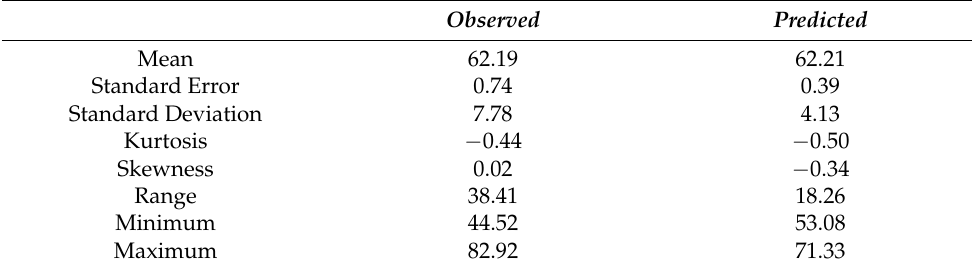
Table 7. Summary Statistics of the Observed and Predicted Noise Levels.